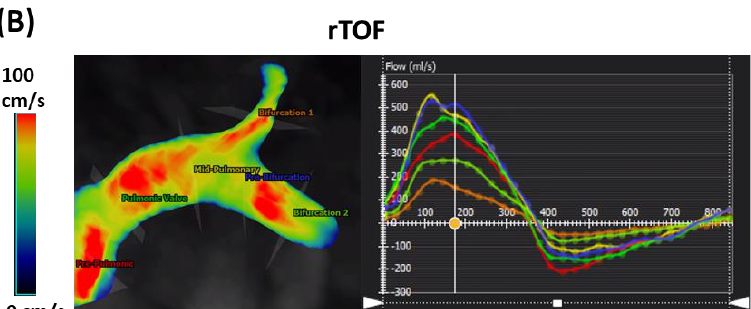
Figure 4. Plane planning and flow assessment along the pulmonary artery using 4D-flow. Velocity mapping is shown in the left and flow chart in the right. The vertical line indicates the phase in the cardiac cycle. Panel ( A ) illustrates the flow analysis of a healthy control. Each plane has an associated color in the flow chart. Panel ( B ) illustrates the flow analysis of a patient with repaired Tetralogy of Fallot. Remark that all planes measured some degree of flow regurgitation.